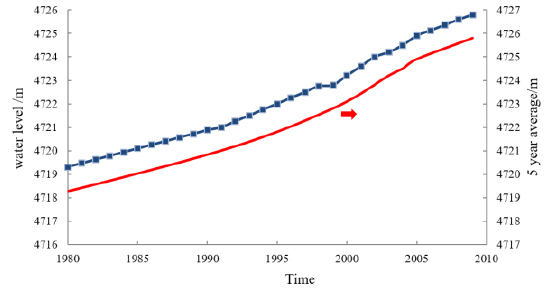
Figure 3. The actual water levels in Nam Co Lake from 1980–2009.